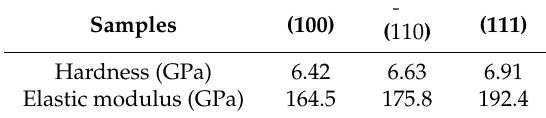
Table 2. Values of hardness and elastic modulus for different